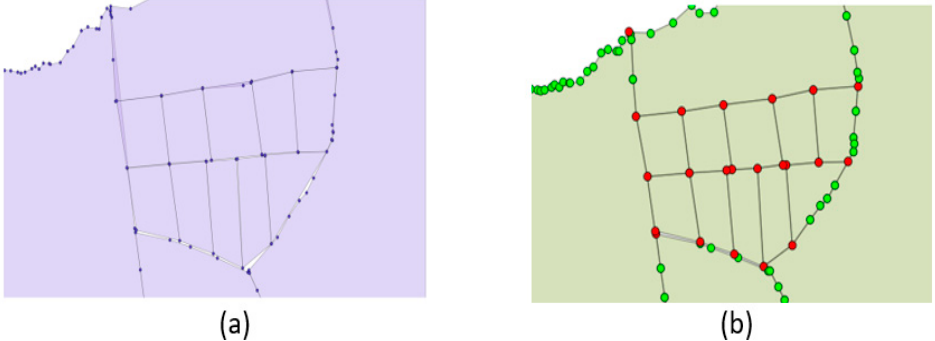
Figure 15. Properties and their points before ( a ), and after ( b ) adjustment.